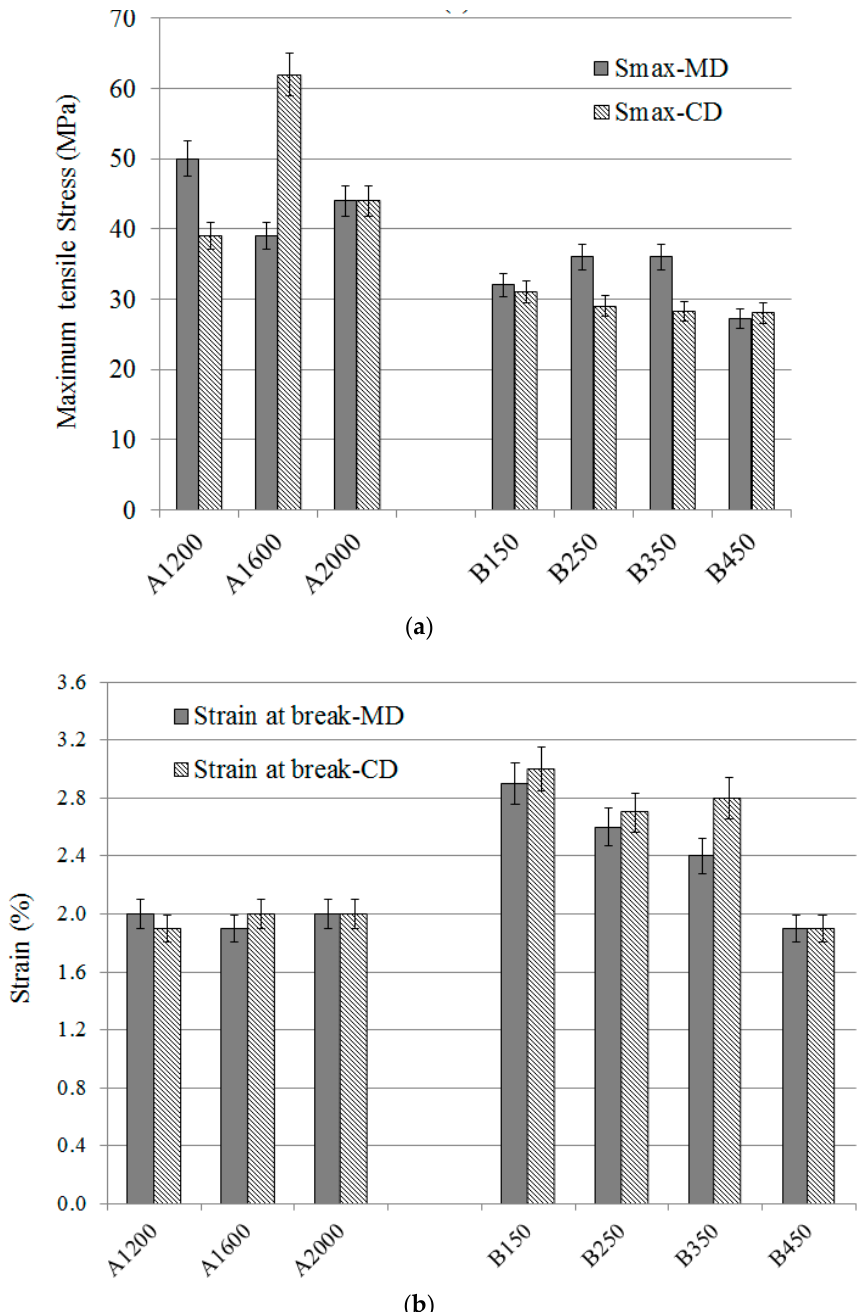
Figure 3. Tensile stress ( a ) and strain at break ( b ) for A and B set nonwovens reinforced composites.